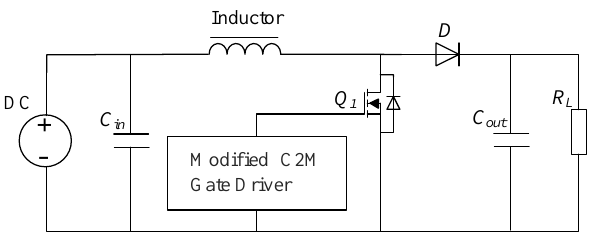
Figure 10. Schematic of the Cree/Wolfspeed boost converter evaluation board.